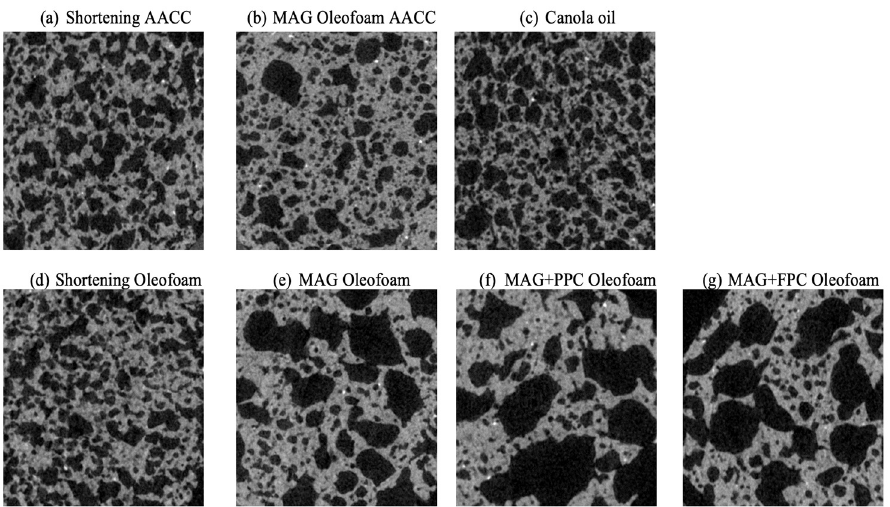
Figure 9. Microtomography images of different cakes. Names of cakes are shown on the top of each image. ( a ) Shortening AACC and ( b ) MAG oleofoam AACC cakes were prepared using the AACC method, and ( c – g ) the rest of the cakes were prepared using the new lab-developed batter preparation method. MAG, monoacylglycerols; PPC, pea protein concentrate-stabilized foam; FPC, faba bean protein concentrate-stabilized foam.